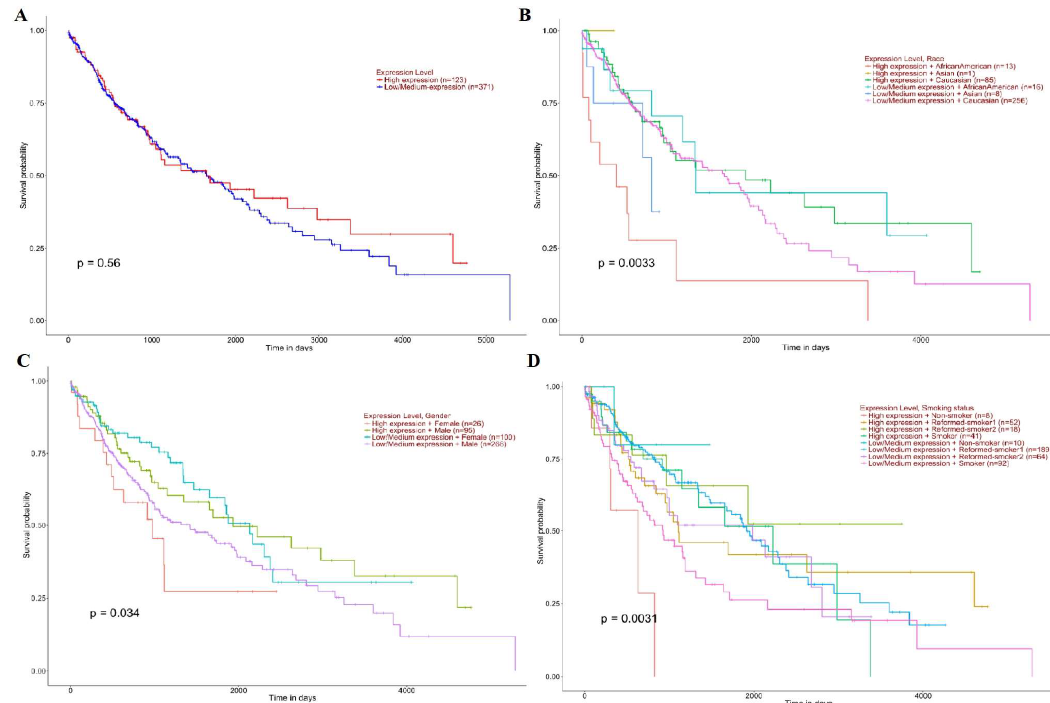
Figure 6. Prognostic roles of SLC3A2 in different subgroups of LUSC patients. ( A ) Sample type; ( B ) Race; ( C ) Gender; ( D ) Smoking habits.